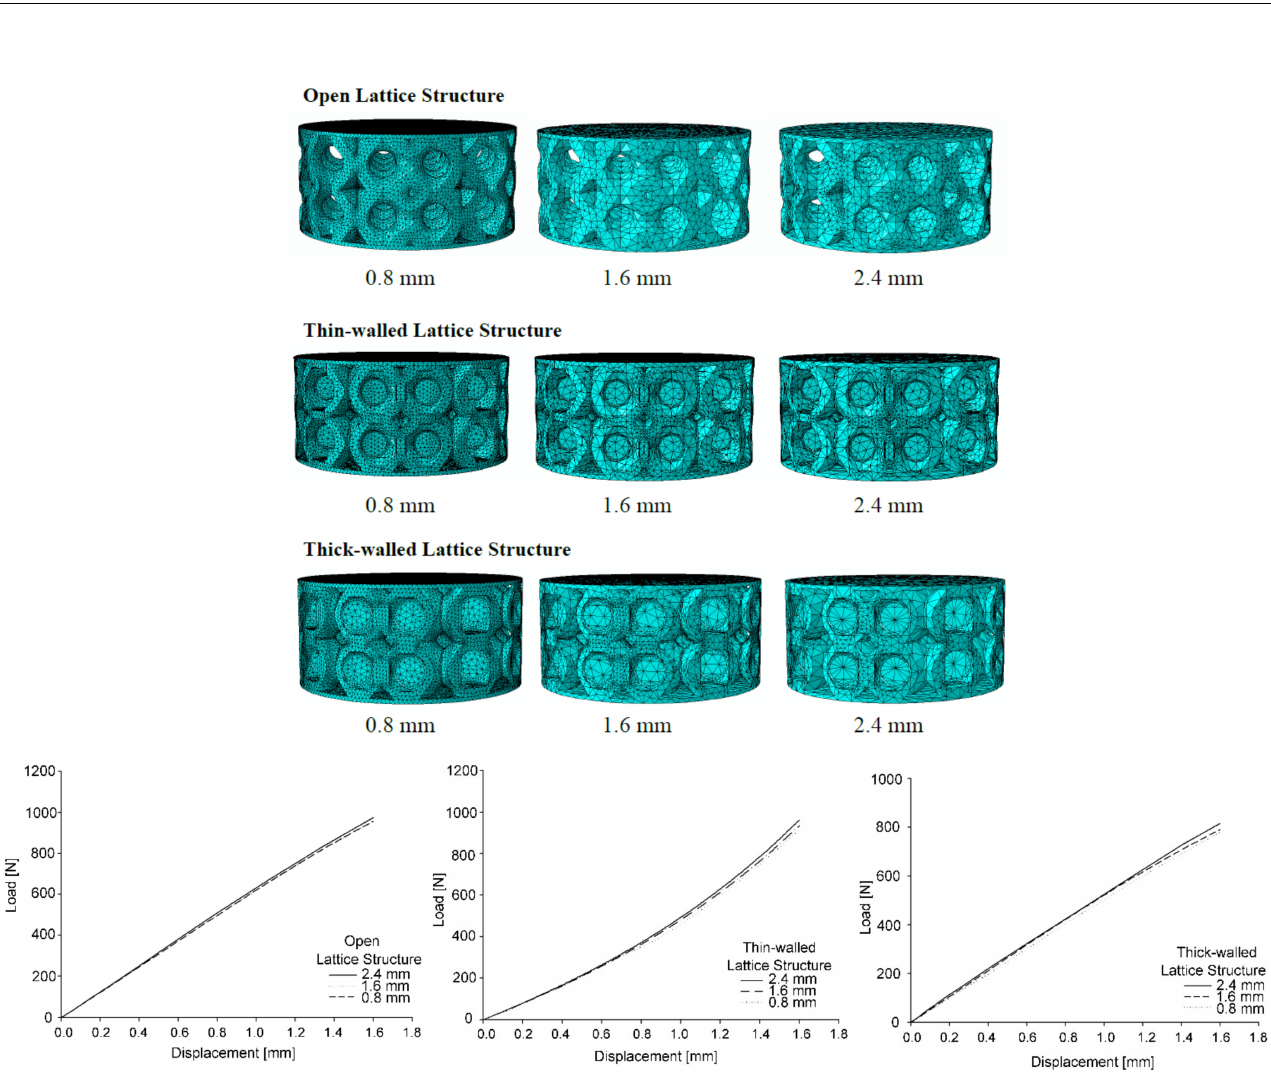
Figure 9. Mesh independency analysis of lattice structures and convergence analysis. Table 5. Mesh of lattice structures: nodes and